Question: Give a one-sentence summary of this figure.
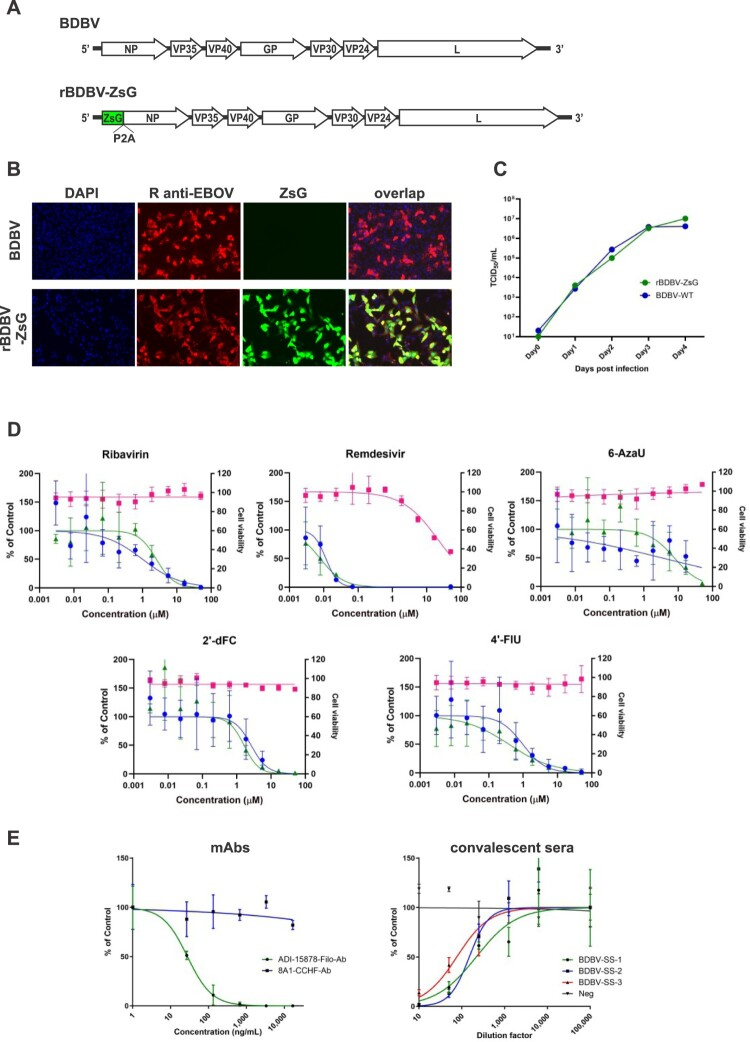
Answer: (A) Schematic representation of the genomes of recombinant Bundibugyo virus (rBDBV) with or without ZsGreen (ZsG) protein. (B) Immunofluorescence assay (IFA) showing Vero-CCL-81 cells infected with wild-type BDBV (BDBV) or rBDBV-ZsG (magnification 20 X; EVOS microscope). (C) Growth curves of indicated viruses in Huh7 cells (Multiplicity of Infection: 0.1). (D) Concentration-response curves in Huh7 cells infected with BDBV-WT (blue circles) or rBDBV-ZsG (green triangles) after treatment with various antiviral compounds. (E) Left panel: Concentration-response curves in Vero-CCL-81 cells infected with rBDBV-ZsG after neutralization with anti-filovirus (ADI-15878; green line) and anti-CCHFV (8A1; blue line) antibodies. Right panel: Concentration-response curves in Vero-CCL-81 cells infected with rBDBV-ZsG after neutralization with the archived human serum samples.